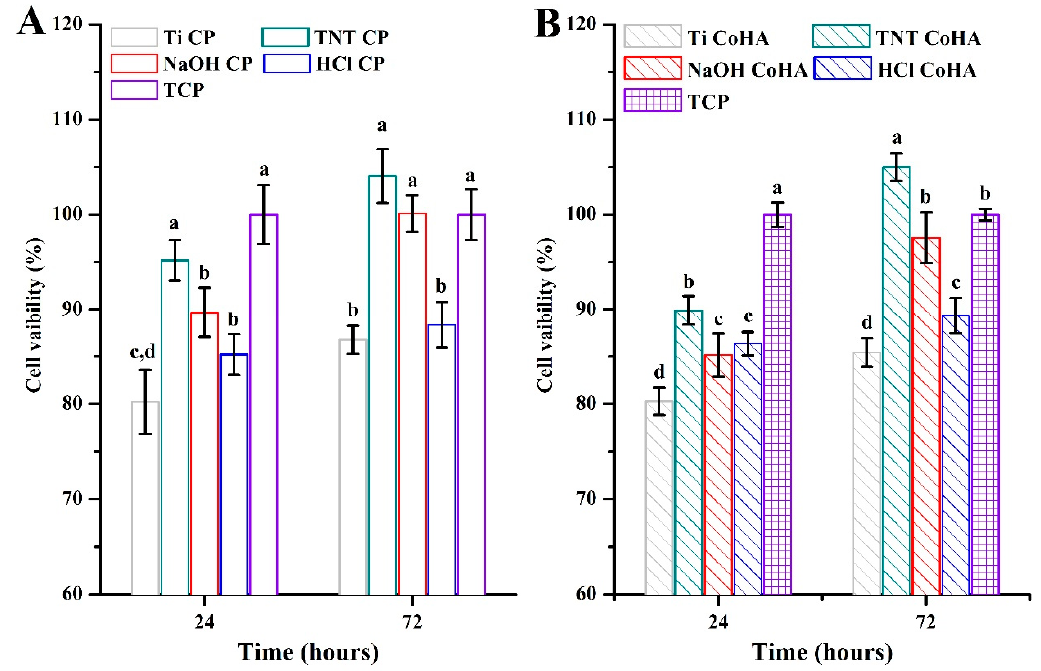
Figure 6. Proliferation determined according to 3-(4,5-dimethylthiazol-2-yl)-2,5-diphenyltetrazolium bromide (MTT) assay of MG63 cell for 24 and 72 h. ( A ) LAB CaP solution. ( B ) LAB CoHA solution. Means with different letters were significantly different ( p < 0.05, mean ± SD, n = 4).